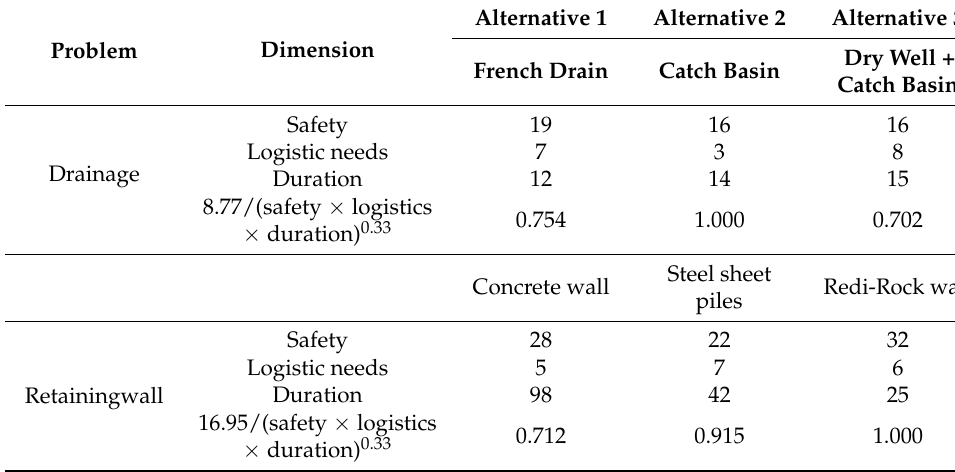
Table 8. Technical/design analysis—overall